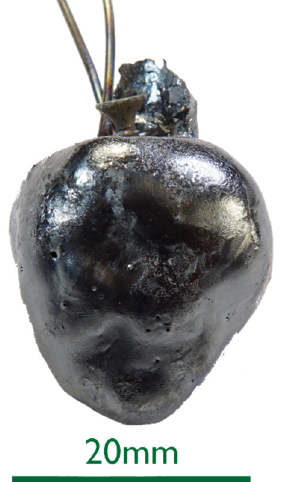
Figure 6. Macroscopic photograph of the sample HBI-ULC-2.